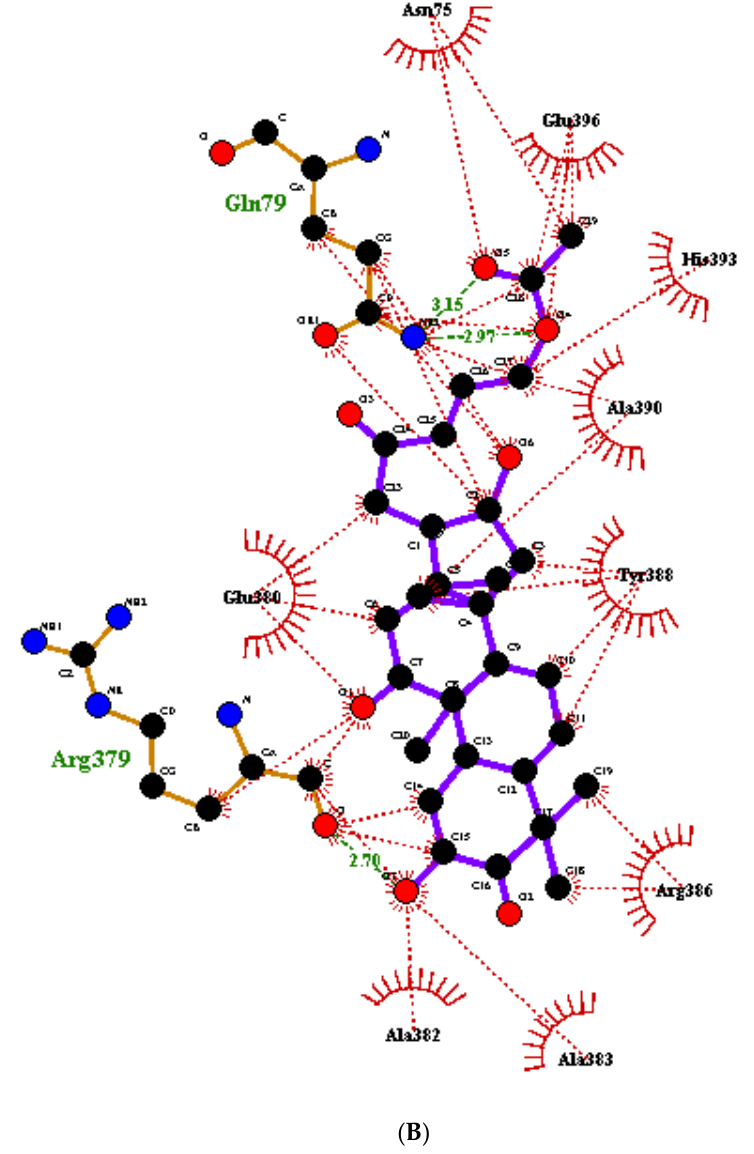
Figure 9. Docking studies and Ligplot+ analysis of Lead molecules. ( A ) Surface representation of a docked complex. ZINC95486305 in sticks (sea-blue color) representation docks firmly within the active site pocket. ( B ) Ligplot diagram of ZINC95486305 lead molecule, purple colored, interacts strongly via three hydrogen bonds with residues Gln79 and Arg379.